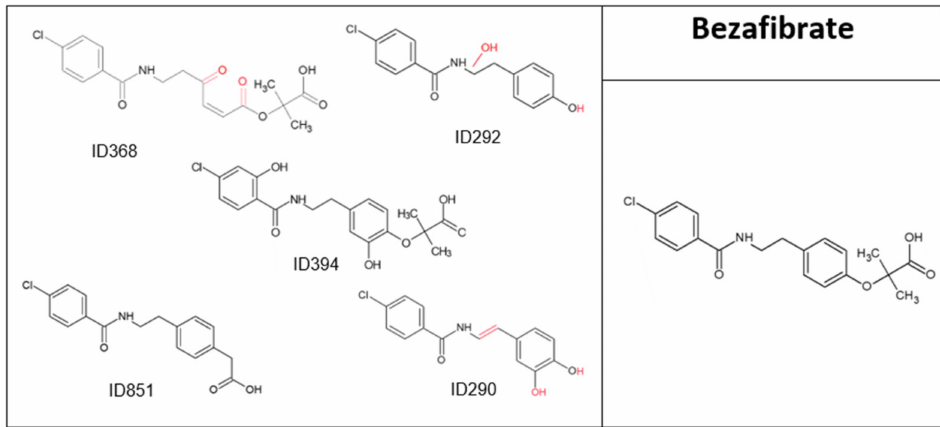
Figure 3. Bezafibrate and its major transformation products. Table 3. Bezafibrate transformation products’ identification